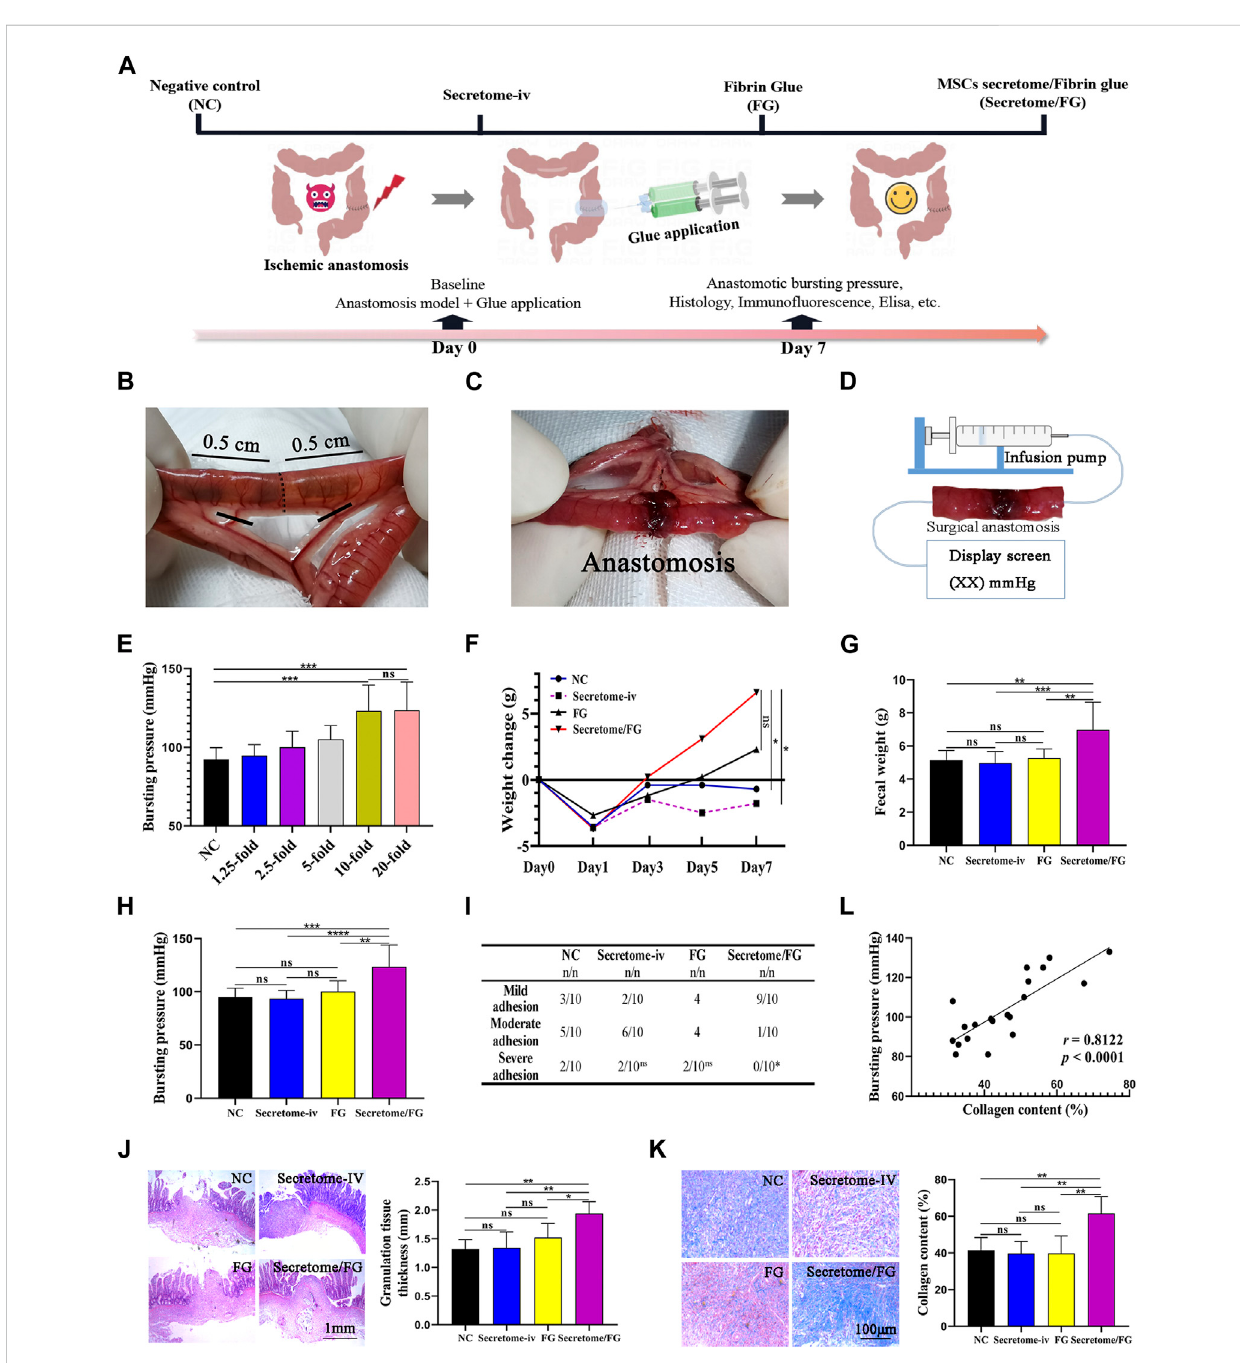
FIGURE 4 MSCs secretome-loaded fi brin glue (Secretome/FG) improves intestinal anastomosis healing in a rat model. (A) Schematic of groups and the experimental design for a 7 days animal study. (B, C) Schematic drawings of blood vessel ligation to induce ischemia in intestinal anastomosis. (D) The method for detecting anastomotic bursting pressure, which is themaximum pressure measuredbyapressuretransducer during thecontinuousinfusion of air into the sealed isolated intestine containing surgical anastomosis. (E) Screening of optimal secretome concentration by bursting pressure analysis of intestinal anastomosis. Overall, MSCs secretome at a concentration of 10-fold is the optimal concentration to improve intestinal anastomosis healing ( n = 10 per group; ANOVA). (F, G) The change in body weight and fecal weight indicates that the rats treated with Secretome/FG promoted a signi fi cantrecoveryofgastrointestinalfunctionatPOD7comparedwiththenegativecontrolgroup(NC)( n =10pergroup;ANOVA). (H) Thecomparison of anastomotic bursting pressure by different interventions ( n = 10 per group; ANOVA). (I) The scoring analysis reveals that Secretome/FG reduced the abdominal adhesion on the 7th day after surgery compared with other interventions ( n = 10 per group; Chi-Square Test). (J, K) The histological and quantitative analysis by HE and Masson staining shows that the repair of intestinal anastomosis depends on the regenerated granulation tissues for all interventions,inwhichthegranulationtissuesarethethickestwiththemostcollagencontentfortheSecretome/FGtreatment( n =5pergroup;ANOVA). (L) The correlation analysis of individual bursting pressure values with collagen content ( n = 5 per group; Pearson ’ s correlation analysis). **** p < 0.0001, *** p < 0.001, ** p < 0.01, * p < 0.05, ns ≥